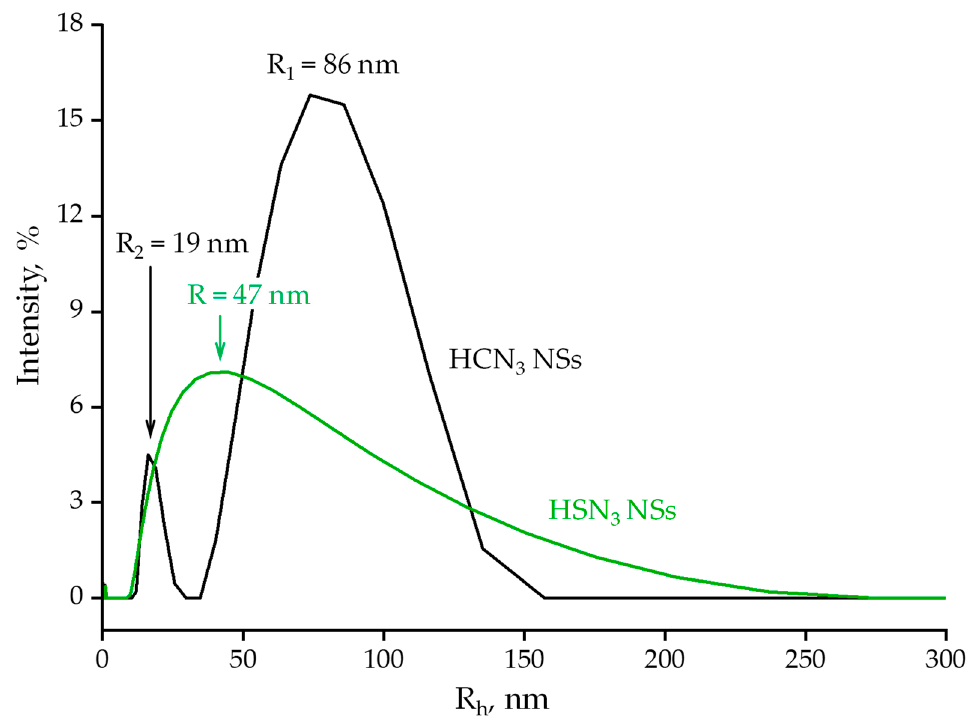
Figure 4. Particle size distributions in as-prepared suspensions of HBN 3 nanosheets.